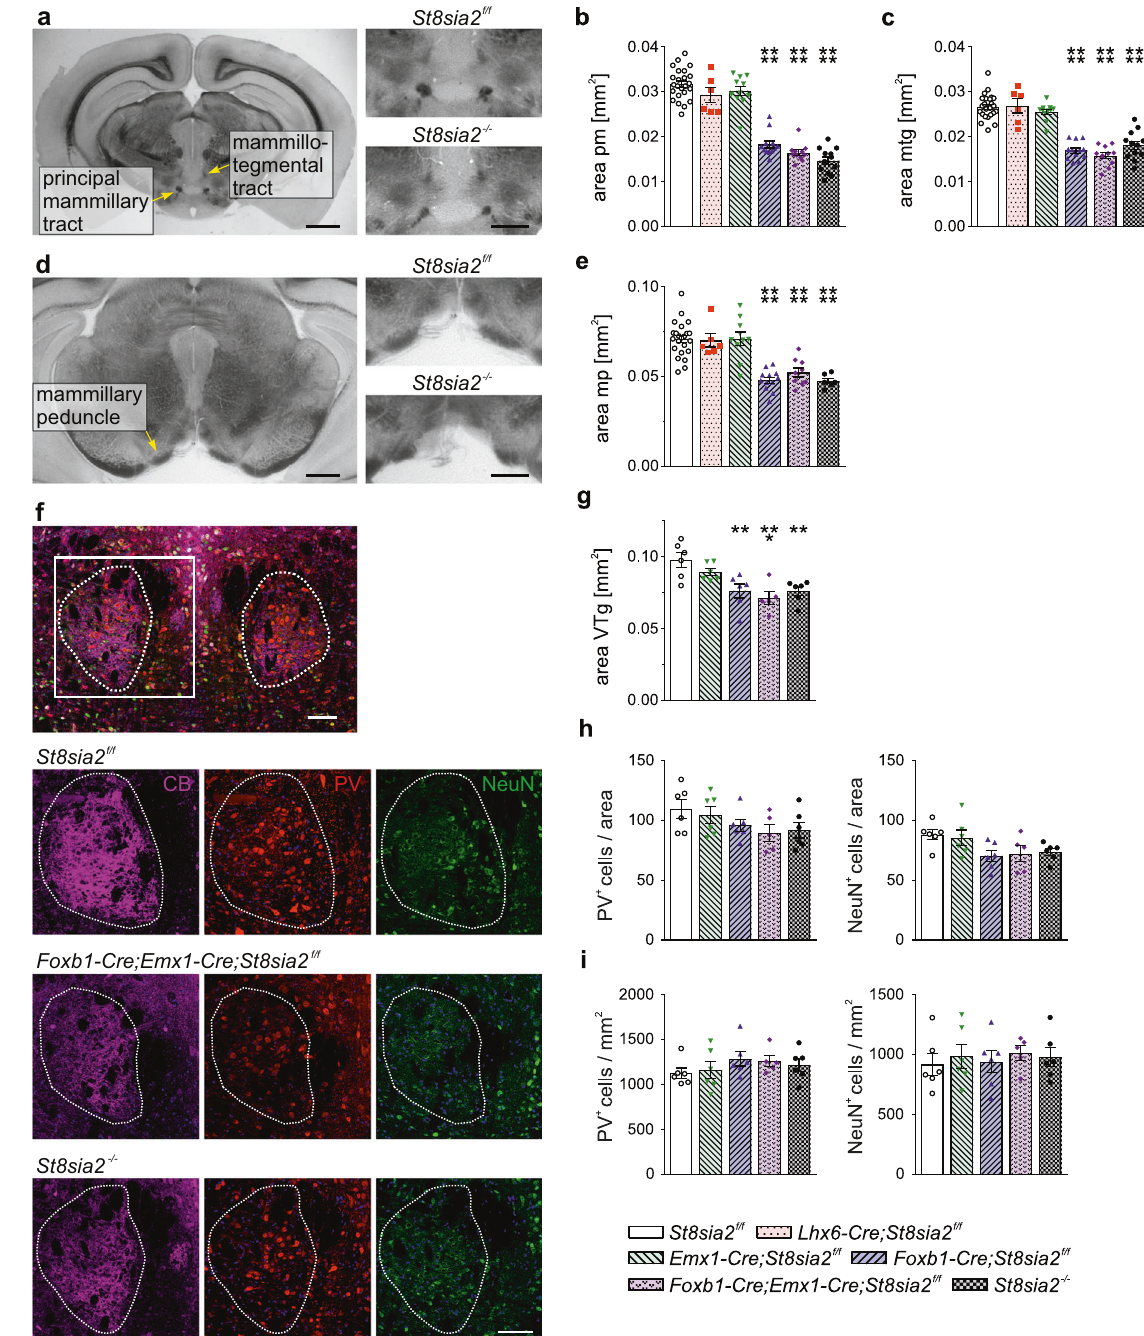
Fig. 3 Ablation of St8sia2 by Foxb1 - Cre affects tegmental connectivity of the MB. a – e Representative images of crossections ( a , d ) and evaluations of crossectional areas of the principle mammillary tract (pm, b ) and the mammillotegmental tract (mtg, c ) at bregma − 2.70 mm, and the mammillary peduncle (mp) at bregma − 3.28 ( e ). Scale bars, 1 mm (overviews) and 500 µm (higher magni fi cations). Graphs show means ± SEM and individual data points of n = 24, 6, 11, 12, 11 and 12 ( b , c ) or n = 23, 6, 10, 12, 9, and 6 ( e ) St8sia2 f/f , Lhx6-Cre;St8sia2 f/f , Emx1- Cre;St8sia2 f/f , Foxb1-Cre;St8sia2 f/f , Foxb1-Cre;Emx1-Cre;St8sia2 f/f , and St8sia2 − / − mice, respectively. One-way ANOVA indicated signi fi cant differences ( p < 0.0001; F 5,70 = 82.54 in b , F 5,73 = 48.90 in c , F 5,60 = 19.24 in e ). Holm – Sidak ’ s post hoc tests were applied and signi fi cant differences for comparisons with St8sia2 f/f controls are indicated (**** p < 0.0001). f Triple immuno fl uorescent staining for calbindin (CB, magenta), parvalbumin (PV, red), and NeuN (green) of the ventral tegmantal nuclei (VTg, dotted outline) on coronal sections of brains from P90 mice at bregma level − 4.90 mm. Overview (upper panel) and representative single channel views of the indicated genotypes. Scale bars, 100 µm. g – i Evaluation of the crossectional area of the VTg ( g ), the numbers ( h ) and the densities ( i ) of PV- and CB-posit i ve cells in the crossectional area of the VTg. Graphs show means ± SEM and individual data points of n = 5 Foxb1-Cre;Emx1-Cre;St8sia2 f/f mice or n = 6 St8sia2 f/f , Emx1-Cre;St8sia2 f/f , Foxb1-Cre;St8sia2 f/f , and St8sia2 − / − mice, respectively. One-way ANOVA indicated signi fi cant differences with p = 0.0007 for the areas in ( g ) (F 4,24 = 6.992), but not for the numbers or densities of PV- and CB-positive neurons in ( h ) and ( i ) ( p = 0.22, F 4,24 = 1.55 and p = 0.059, F 4,24 = 2.630 for PV and NeuN in h ; p = 0.94, F 4,24 = 0.19 and p = 0.55, F 4,24 = 0.79 for PV and NeuN in i ). Holm – Sidak ’ s post hoc test was applied for data in ( g ) and signi fi cant differences for comparisons with St8sia2 f/f controls are indicated (** p < 0.01, *** p < 0.001). When compared to Emx1-Cre;St8sia2 f/f , differences with p < 0.05 were only observed for Foxb1-Cre;Emx1-Cre;St8sia2 f/f